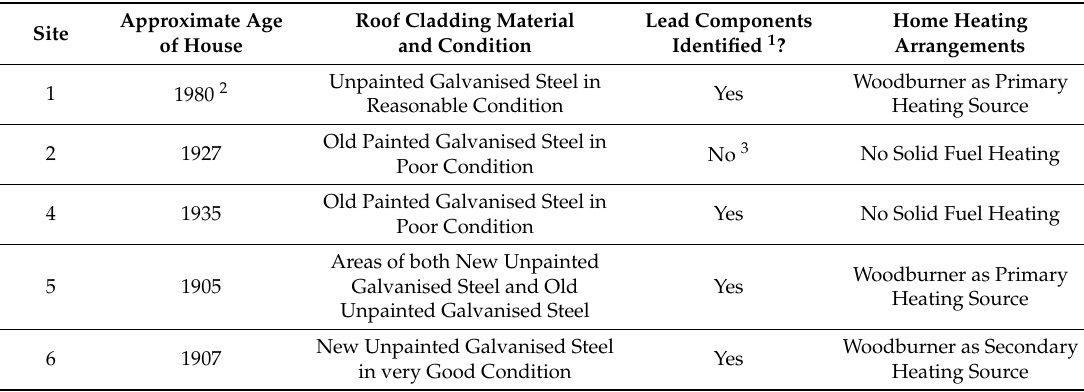
Table 1. Roof catchment characteristics at the study sites.